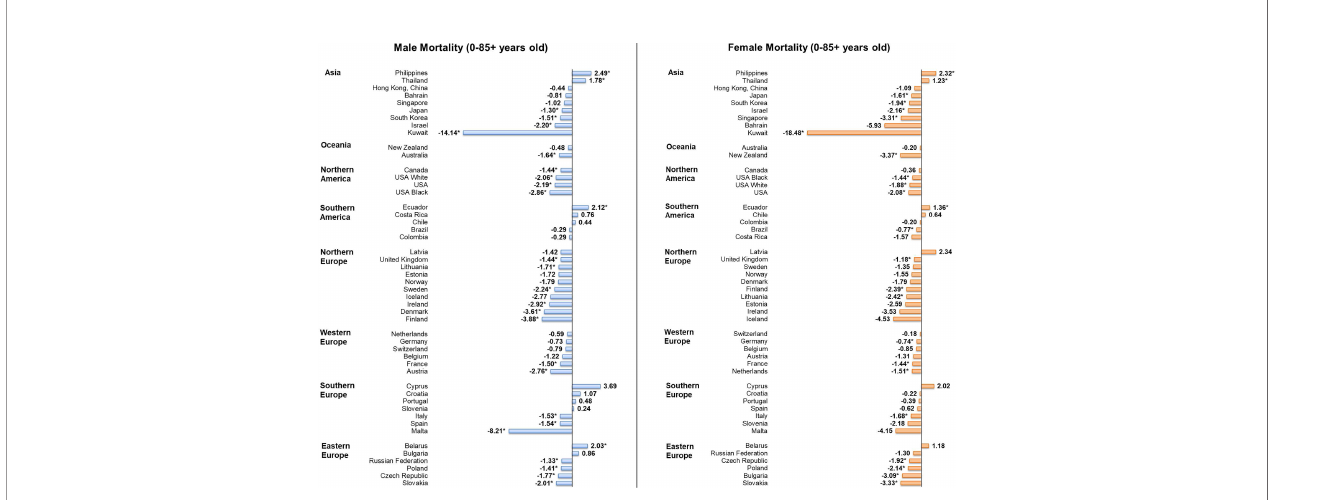
FIGURE 5 | AAPC of mortality of leukaemia in individuals aged 0 – 85+ years old. * p values <